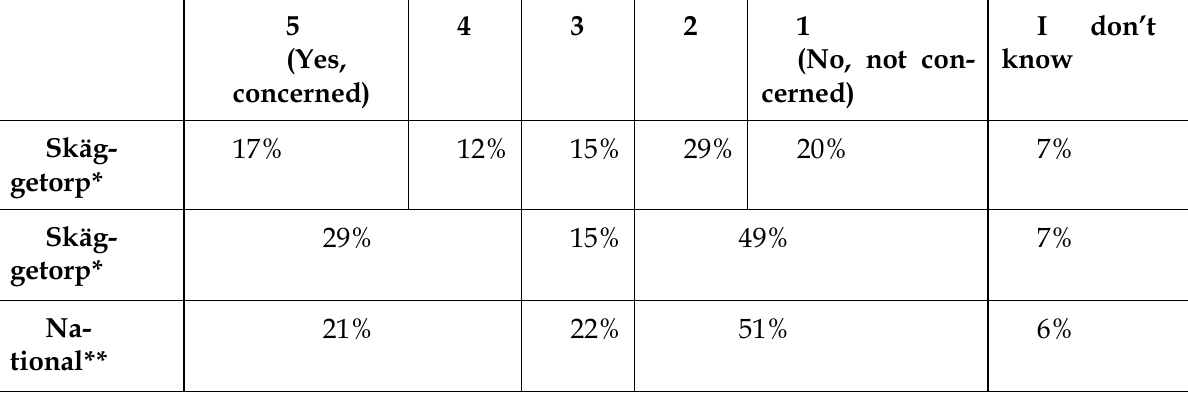
Table 3. Concern that Swedish authorities are breaching your personal privacy on the internet.